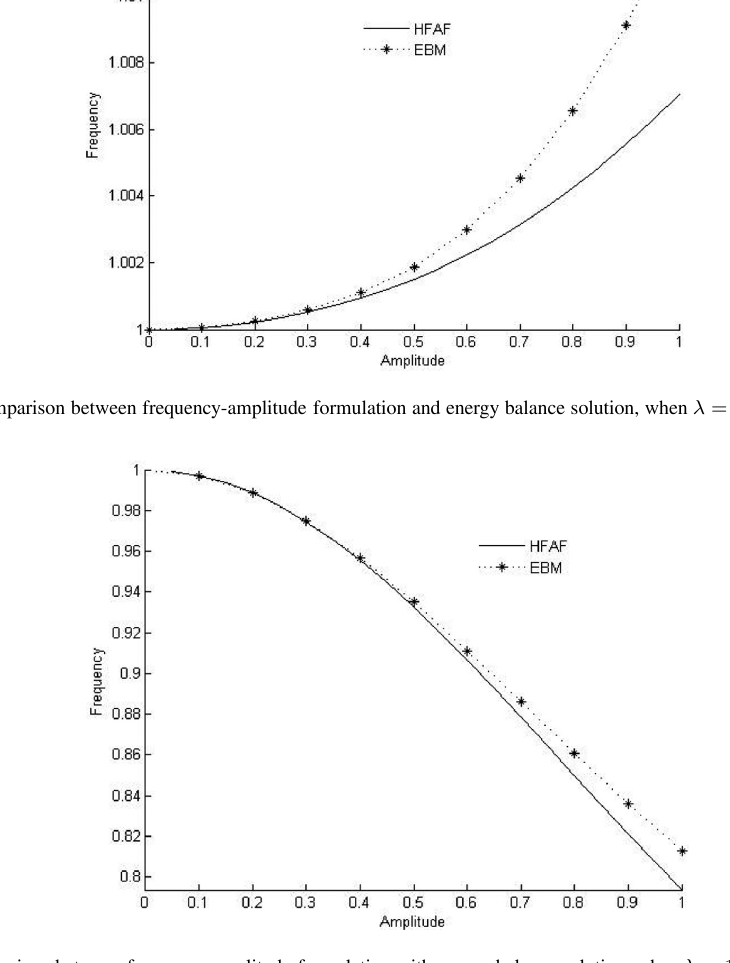
Fig. 8. The comparison between frequency-amplitude formulation with energy balance solution, when λ = 1 , for the second mode. u ( t ) = A cos